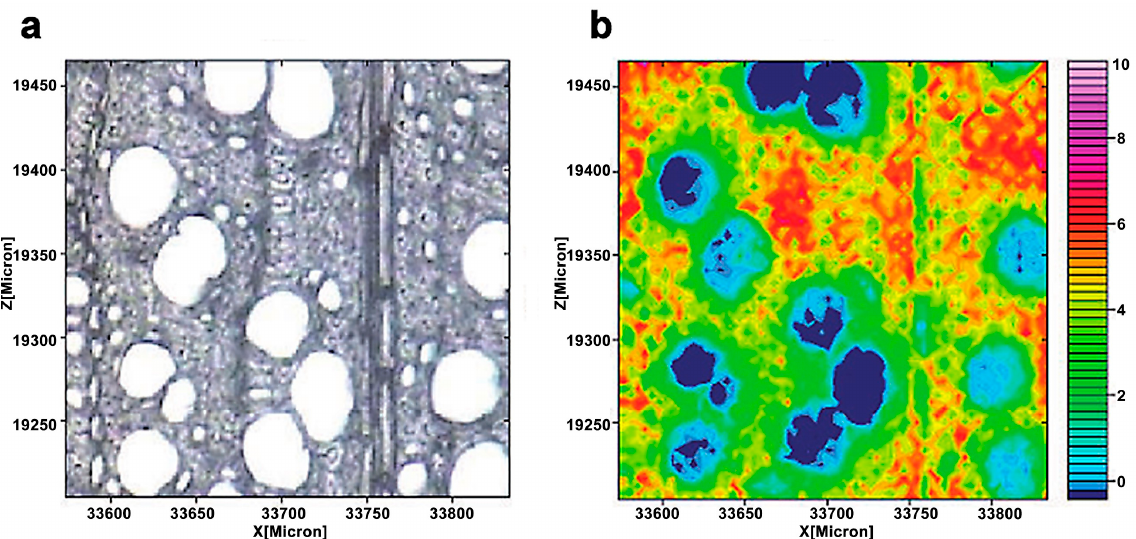
Figure 10. A light microscopic image of a cross-section of a beech ( a ). The lignin distribution was seen by combining the spectra pictures for the wavenumber range 1530–1490 cm − 1 ( b ). From blue (low) to pink (high), the color scale denotes increasing cellulose concentration.